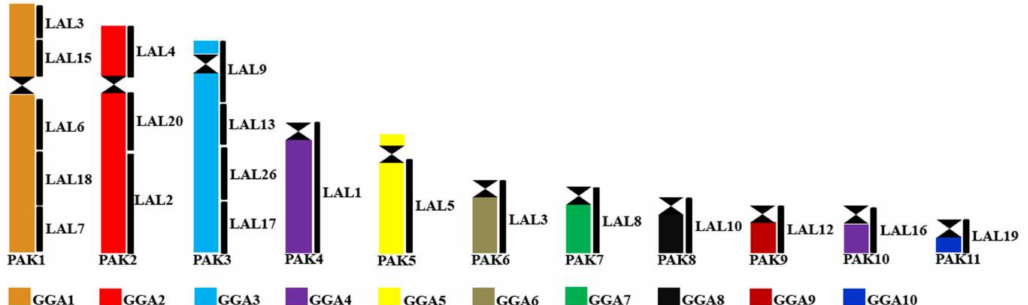
Figure 3. Refined putative avian ancestral karyotype, based on the homology with Leucopternis albicollis . GGA: Gallus gallus ; LAL: Leucopternis albicollis ; PAK: Putative Avian Ancestral